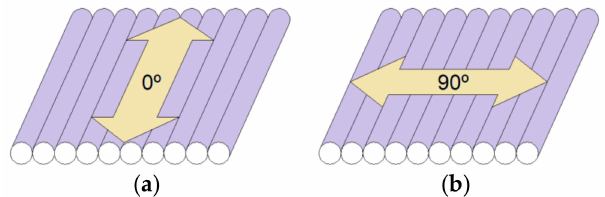
Figure 2. Measurement of surface roughness in the direction parallel to the direction of extrusion ( a ) and in the direction perpendicular to the direction of extrusion ( b ). Table 3. Test dataset: design of experiment ( L 27 ), according to Taguchi method: layer height